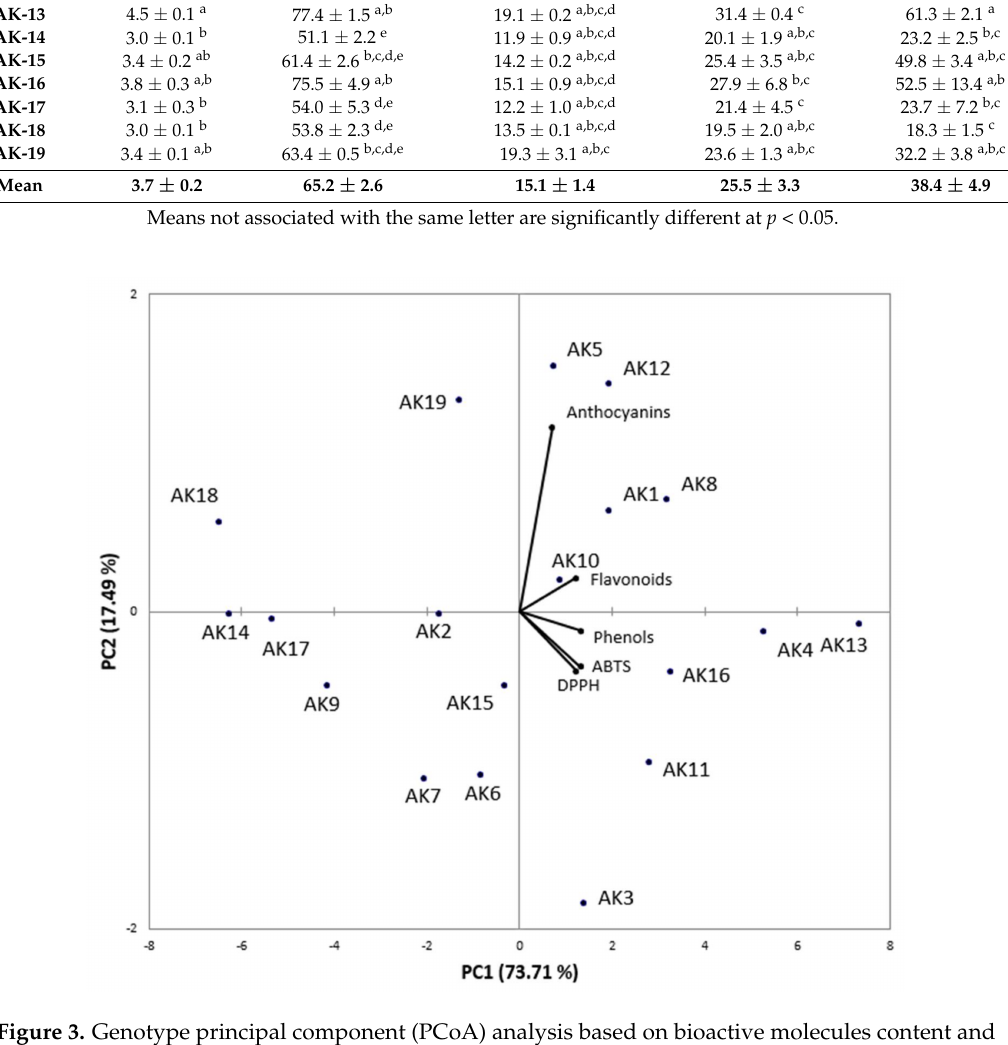
Figure 3. Genotype principal component (PCoA) analysis based on bioactive molecules content and antioxidant